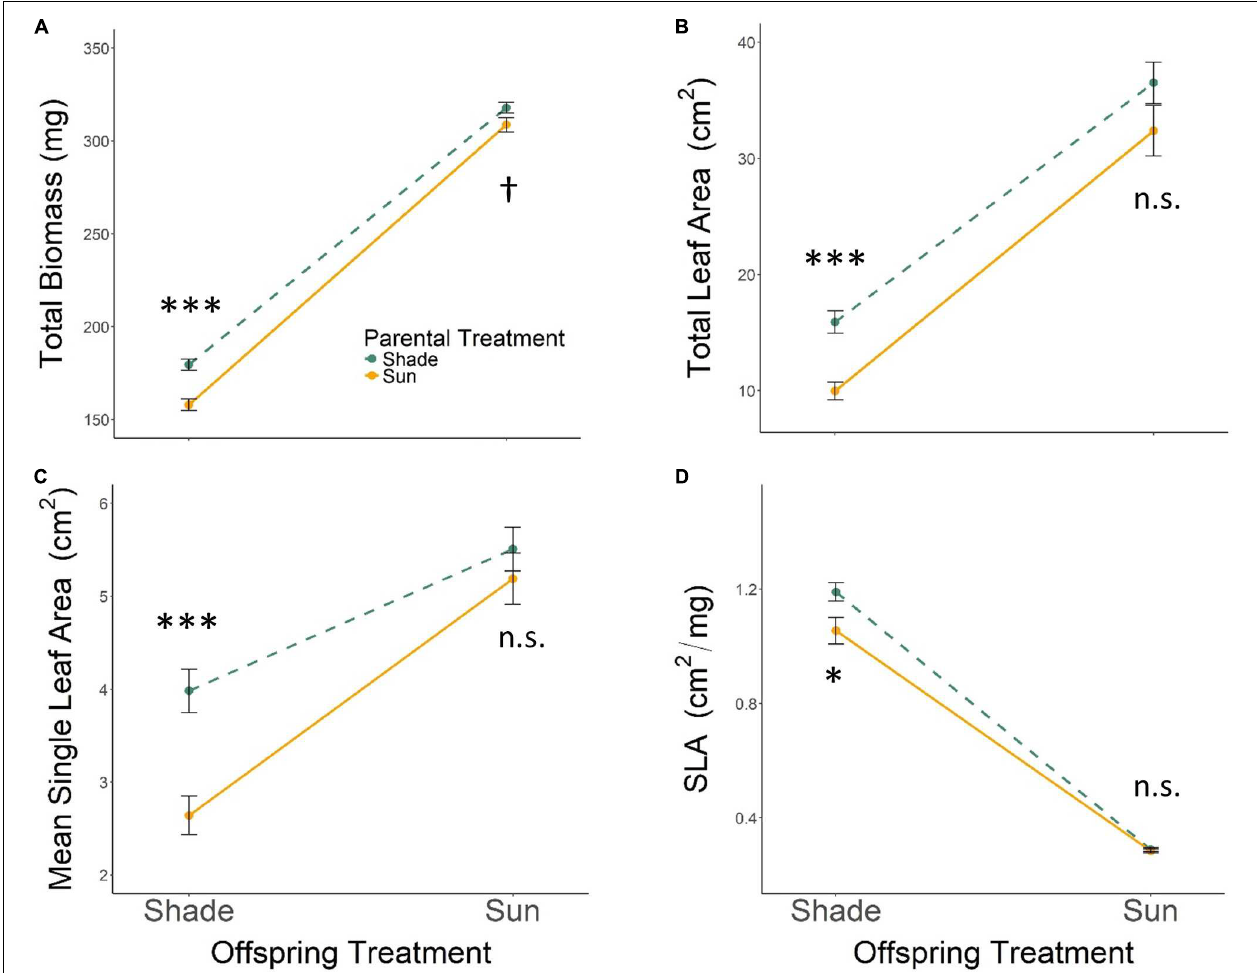
FIGURE 1 | Means ± SE shown ( N = 184) for (A) total biomass, (B) total leaf area, (C) mean single leaf area, and (D) SLA for offspring of Parental Shade (dashed green line) and Parental Sun (solid yellow line) plants that were grown either in Offspring Shade or Offspring Sun treatments. Results of significant tests for the effect of parental shade versus sun in each offspring treatment are shown, based on separate within-treatment ANOVAs ( † p < 0.10, ∗ p < 0.05, ∗∗∗ p < 0.001, n.s. p > 0.1, see section “Materials and Methods” for details).